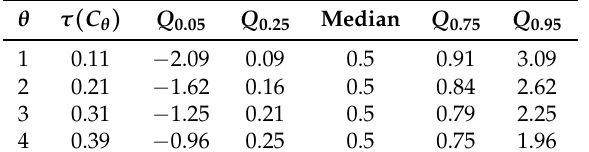
Table 10. Some percentiles of Y = X 1 / ( X 1 + X 2 ) , where ( X 1 , X 2 ) follows Frank Copulas.